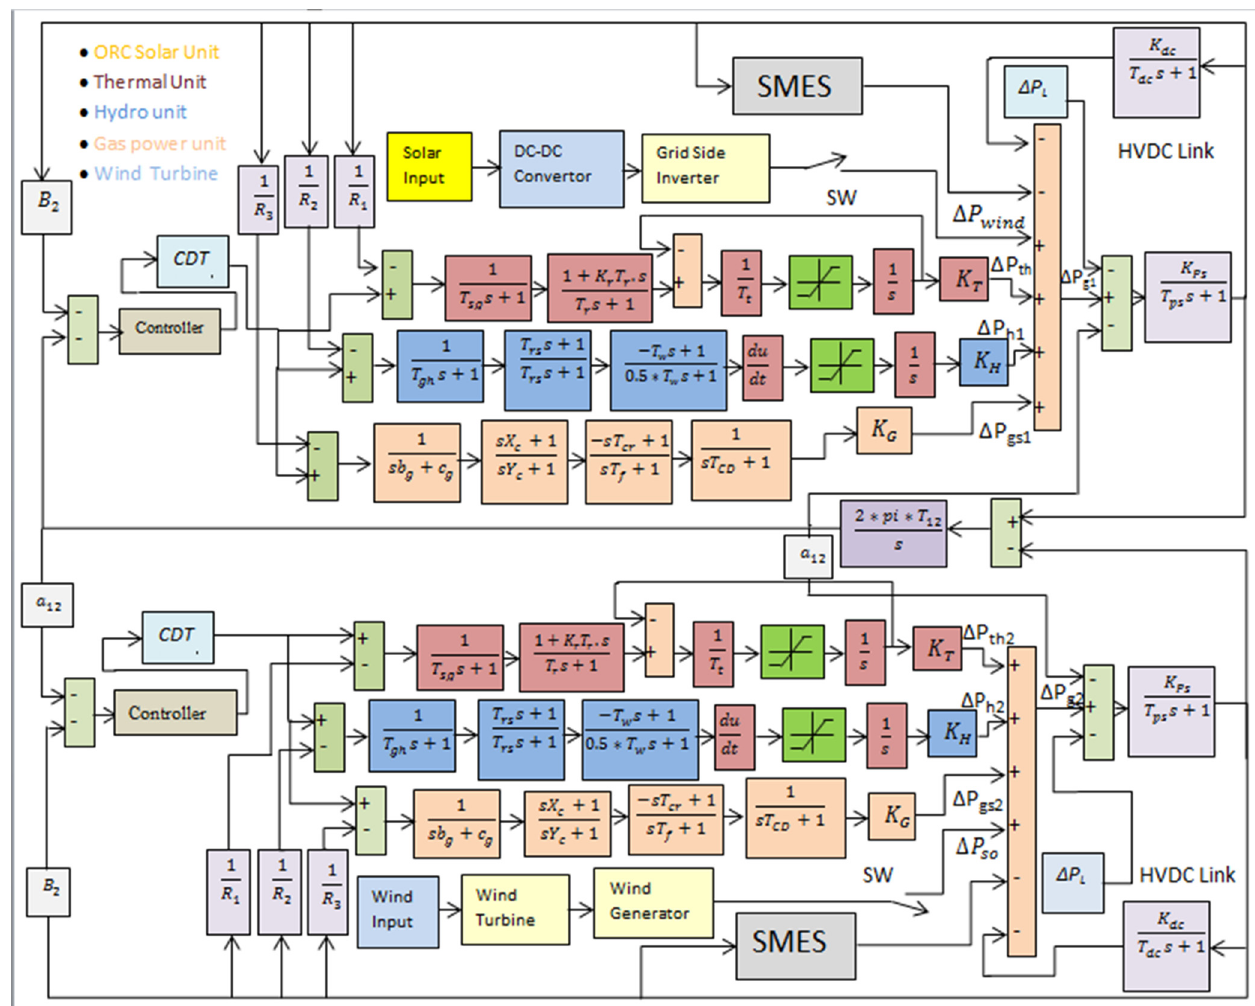
Figure 1. Power system model .